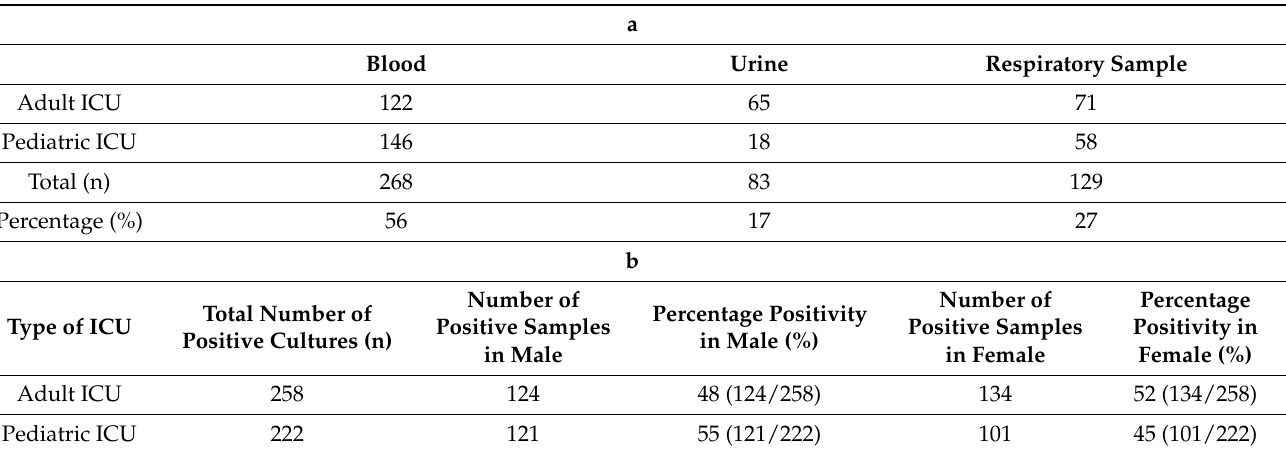
Table 2. ( a ) The percentage (%) of different microorganisms obtained from adult and pediatric ICU from blood, urine, and respiratory samples. ( b ) The percentage culture positivity (%) in male and female patients in adult and pediatric